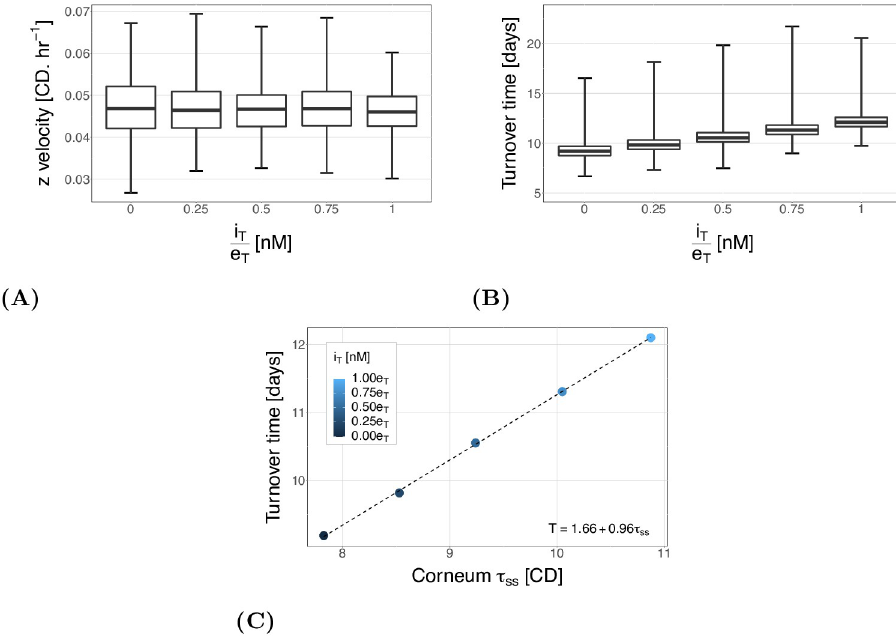
Fig 6. (A) The mean vertical cell velocity for different levels of inhibitor. The box plot shows the quartiles, and the error bars give the minimum and maximum across all cells and simulations. The velocity profile is similar across all setups. (B) The cell turnover time, from birth to desquamation, for different levels of inhibitor. The box plot shows the quartiles, and the error bars give the minimum and maximum across all cells and simulations. The box plot shows there are a large number of outlier cells with high turnover times. (C) The steady state against the cell turnover time. The dashed line is a linear fit to the points, with the equation given in the lower